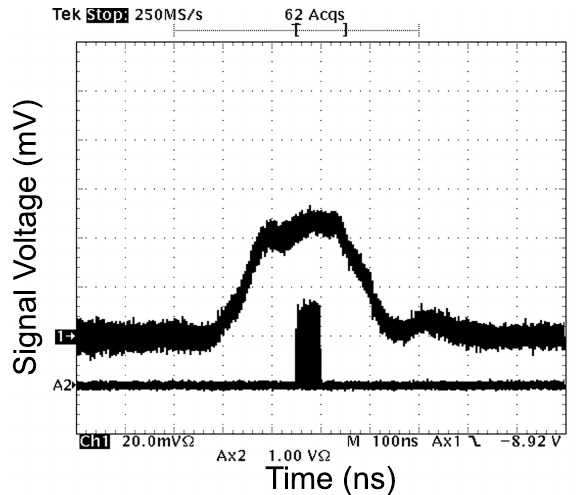
FIG. 10. Several overlain traces demonstrating the extent of shot-to-shot laser arrival timing jitter. The upper trace is the full cell power measured by the monitoring probe, and the lower trace is the signal from a photodiode measuring the laser. The horizontal scale is 100 ns (cid:1) div, and the vertical scale is in arbi- trary